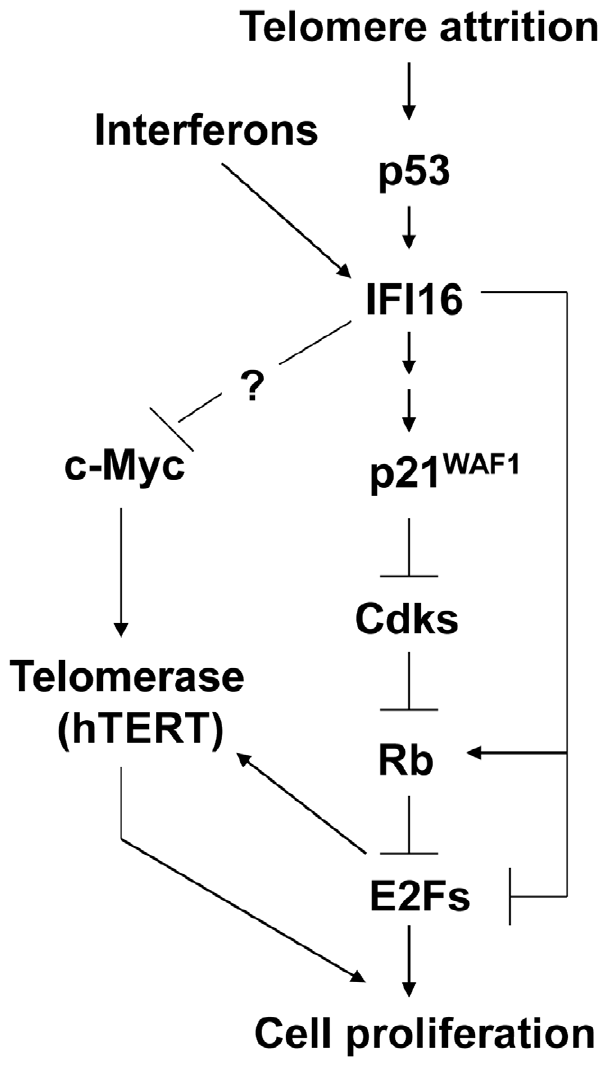
Figure 6. Increased levels of IFI16 protein in human cells inhibit c-Myc-induced expression of the hTERT gene.